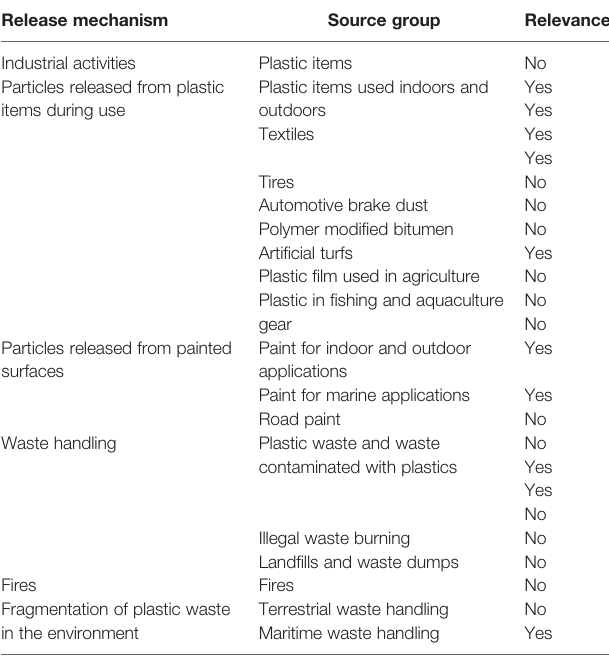
TABLE 2 | Generic secondary MP sources, modi fi ed from (Lassen et al., 2015) with descriptions and relevance to cruise